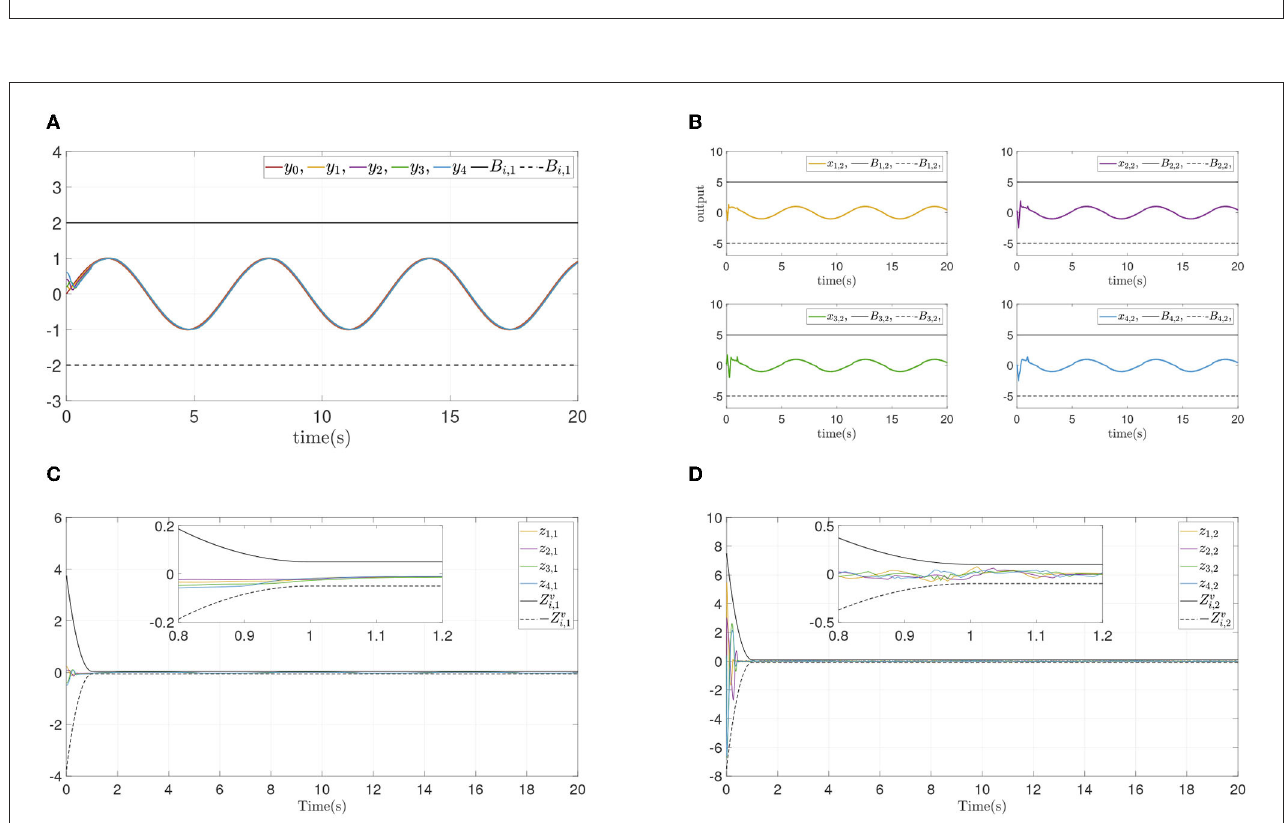
FIGURE7 Simulation results of Example B case II. (A) Followers’ outputs y i . (B) Followers’ states x i ,2 . (C) Synchronization error z i ,1 . (D) Dynamics error z i ,2 .